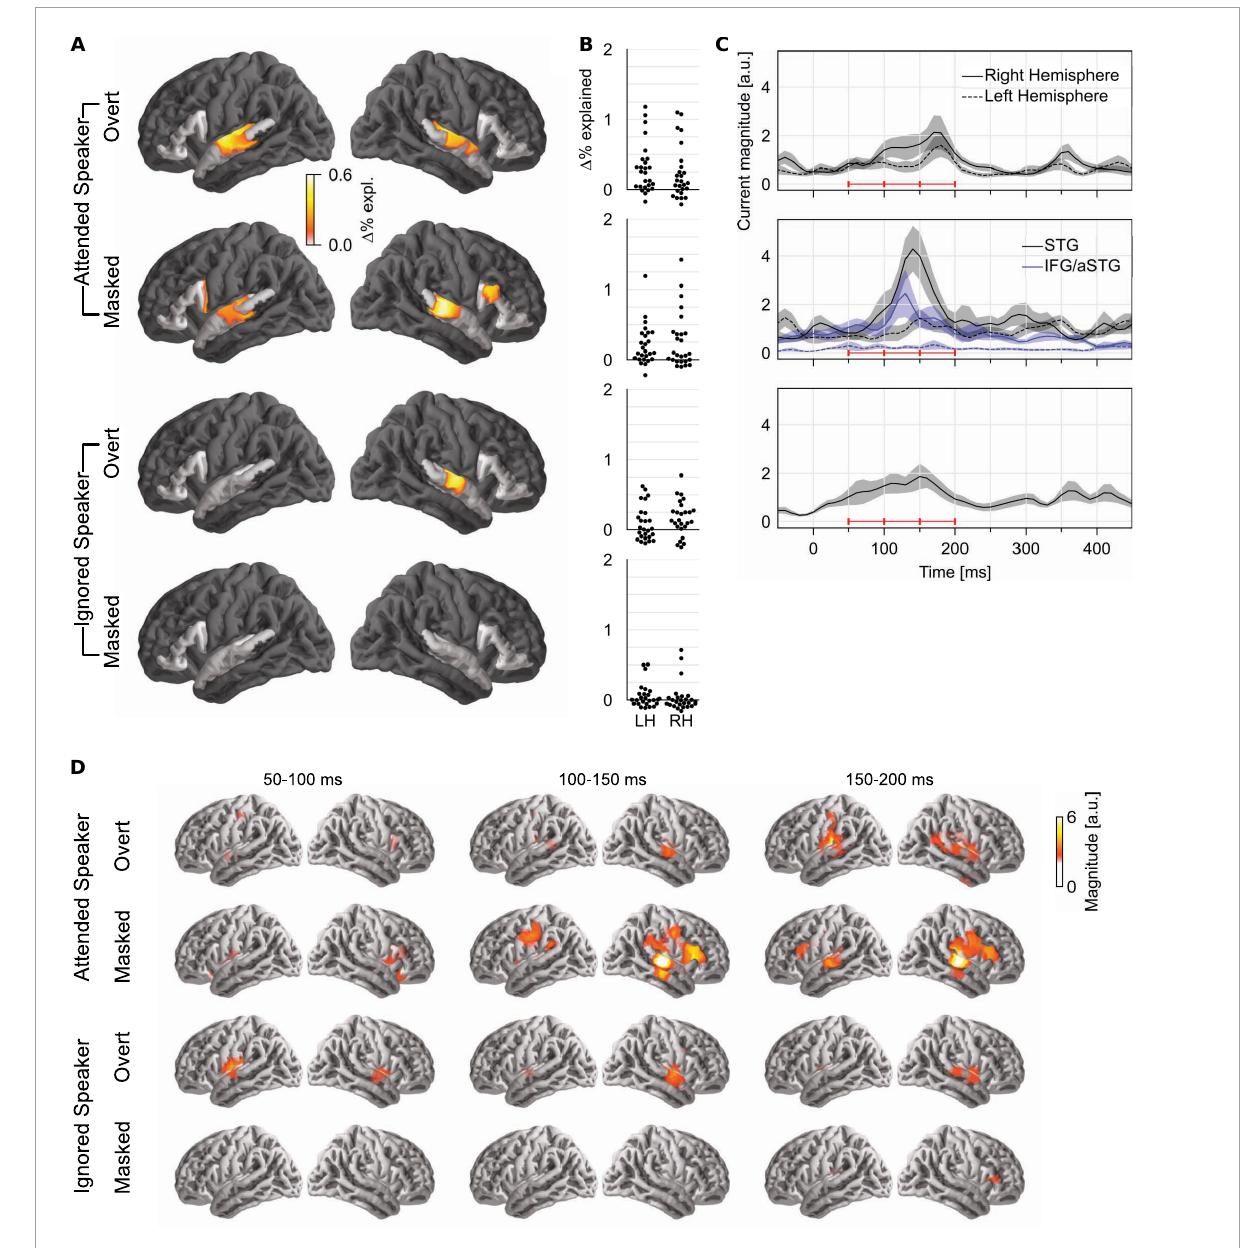
FIGURE3 Pitch tracking in two simultaneous speakers depends on selective attention. (A) Significance tests of pitch tracking for overt and masked pitch in the attended and ignored speakers. STG and IFG were separately tested (darkened area excluded from tests). (B) Individual subject data (% variability explained) in a region of interest, defined as the intersection of the region of significant activity in the single speaker condition and the STG anatomical label. (C) Temporal response function (TRF) magnitude with dominant response at 100–200 ms latency. The three horizontal red bars indicate time windows used in (D) . (D) TRF activity localized mainly to the auditory cortex, with involvement of a more anterior region for masked pitch in the attended speaker. LH, left hemisphere; RH, right hemisphere; STG, superior temporal gyrus; IFG, inferior frontal gyrus; aSTG, anterior